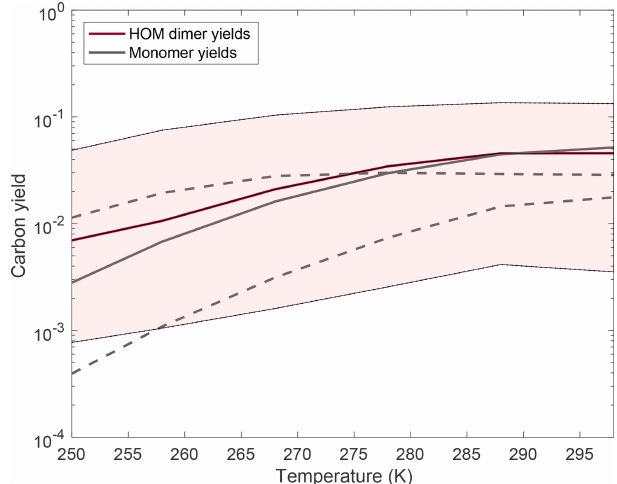
Figure 9. Changes to HOM monomer and dimer yields with an or- der of magnitude variation in the rate coefficient at 298K by chang- ing the autoxidation A factor. The rate coefficient at temperatures other than 298K is calculated in the same manner as described above. Almost all of the yields at a particular temperature are in- creased relative to the traditional case when we assume the rate co- efficient at 298K is higher than the traditional case, and the yields decrease at a particular temperature when we assume the rate co- efficient is lower than the traditional case. The monomer yields decrease with a faster autoxidation rate constant at high temper- atures because with more autoxidation more association reactions successfully form dimers, thus reducing the monomer yields. Quan- titatively, as we vary the rate coefficient of autoxidation by an order of magnitude, we are seeing a corresponding increase or decrease in the HOM product also by about an order of magnitude. The monomer yields are shown in dashed lines and show a more com- plicated trend, with the low barrier monomer yields being higher than the base-case yields at lower temperatures but lower at high